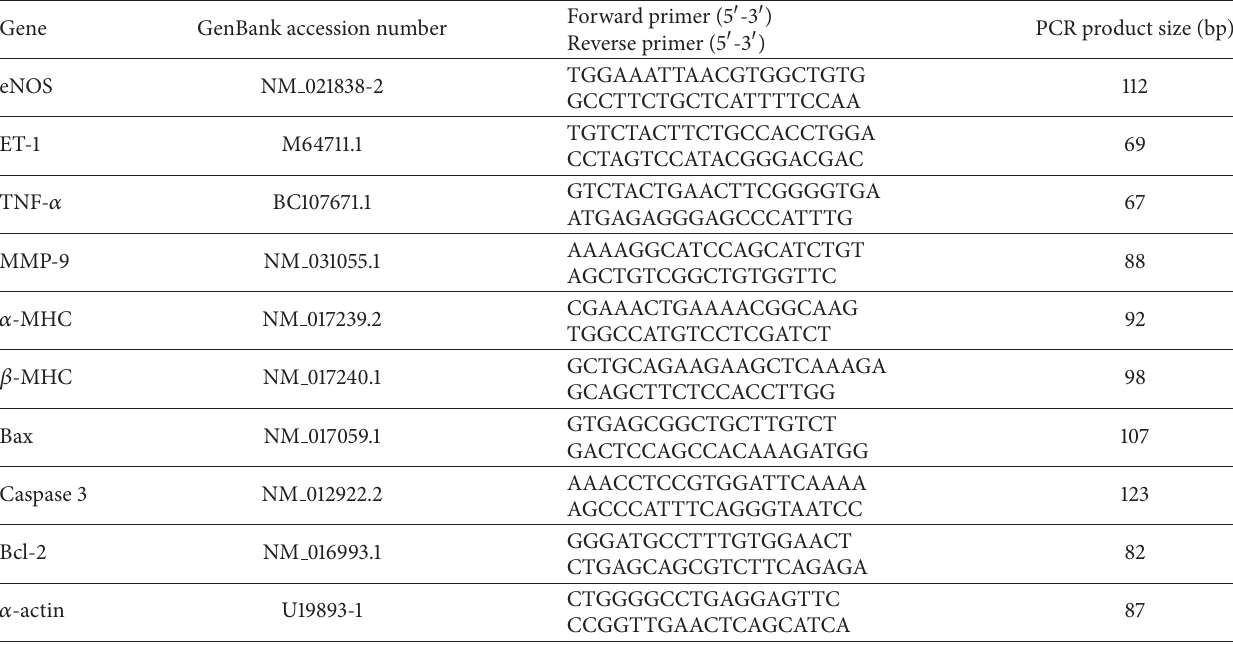
Table 1: Primers used for real-time PCR